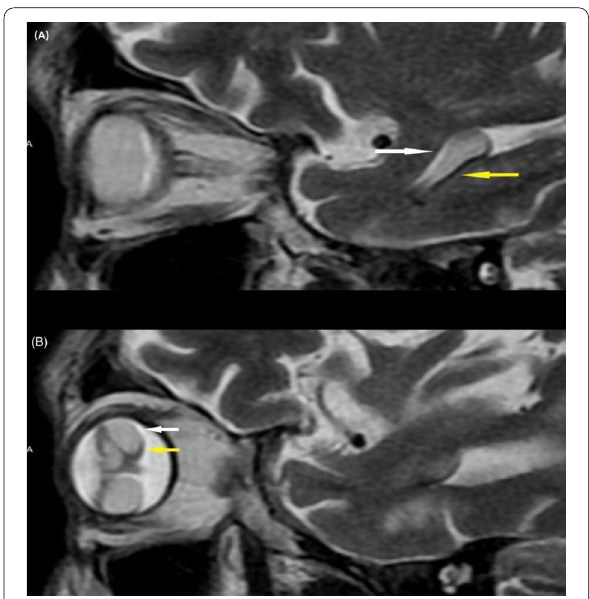
Fig. 4 Sagittal T2W MR images give a better look at the chemical shift artefact produced at the interface by the silicone oil within the temporal horn of the right lateral ventricle ( A ) and the vitreous chamber of the right globe ( B ). A thin curvilinear hyperintense band (white arrows) is noted superior to the globule and a thin hypointense band (yellow arrows) is noted inferior to the